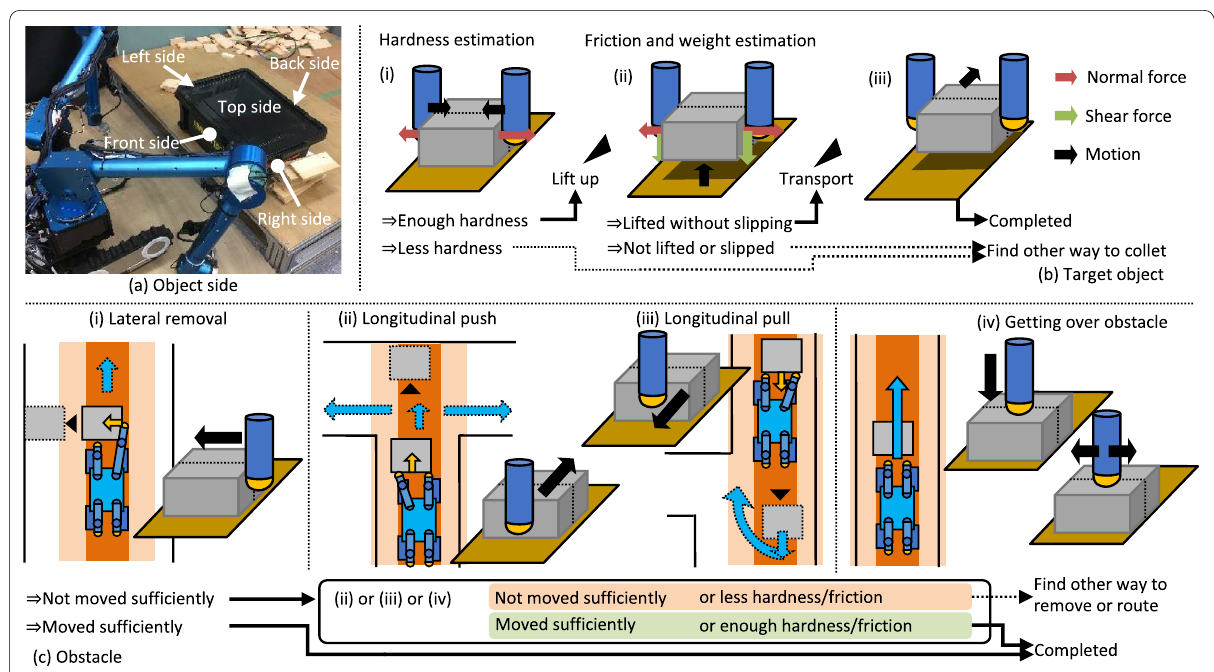
Fig. 5 Design of object groping mode